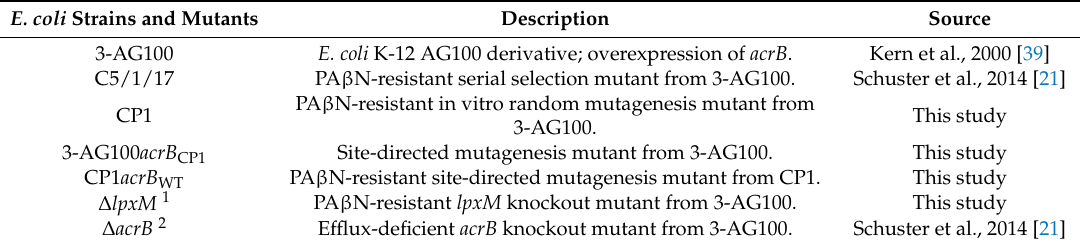
Table 2. Strains and mutants used and engineered in the present